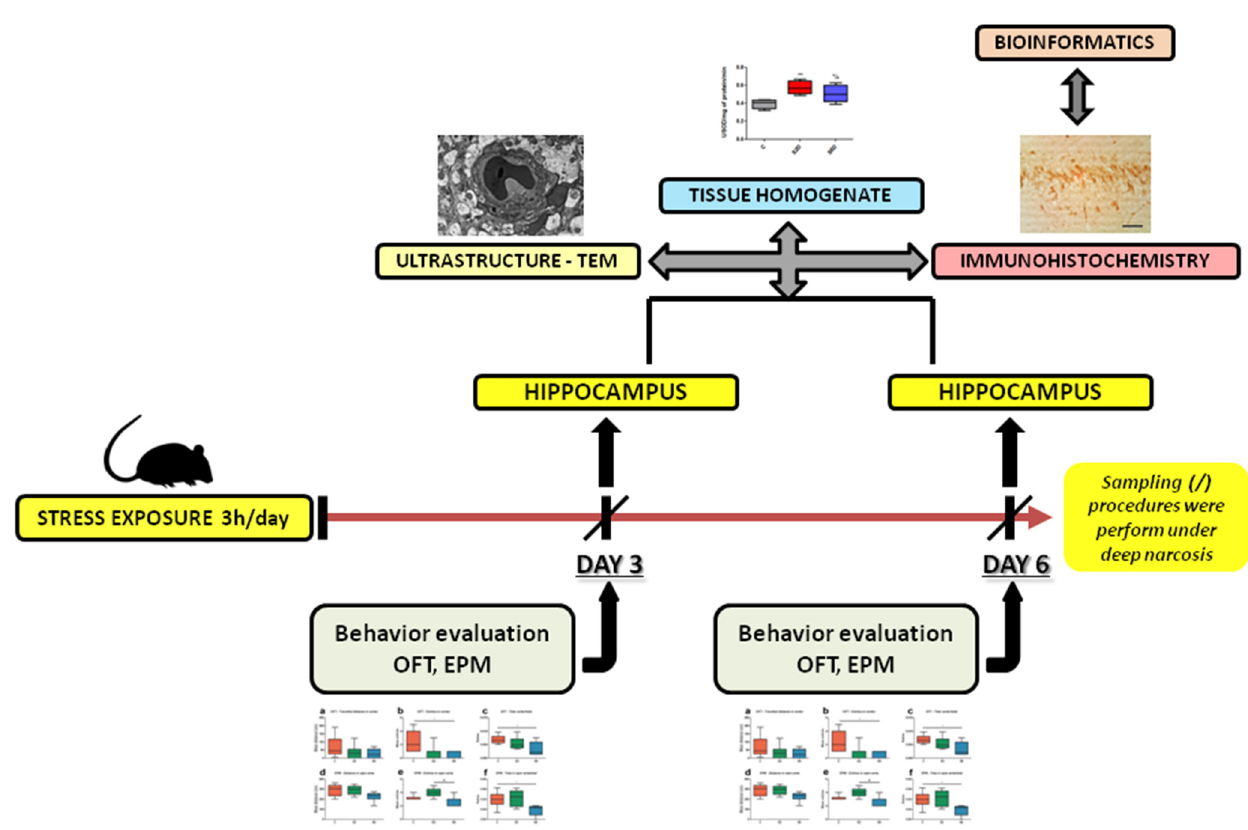
Figure 1. The experimental design that was applied in the current study.